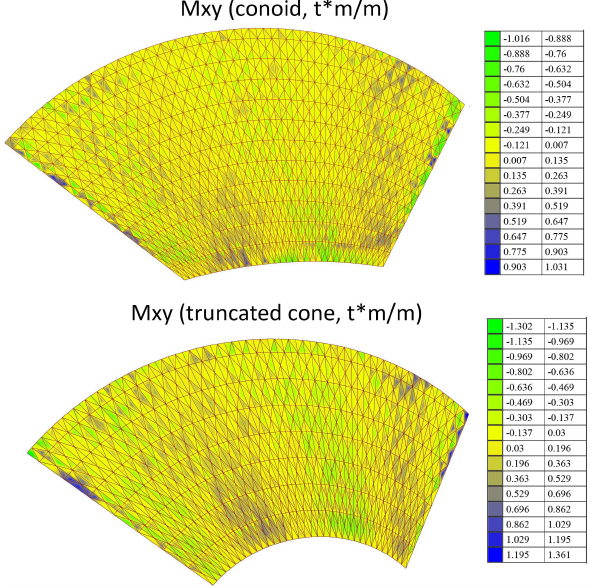
Figure 12: The Mxy parameter of the two shells